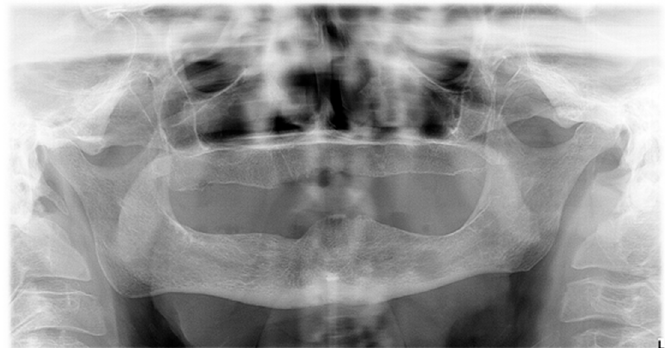
Figure 3. Orthopantomograph.